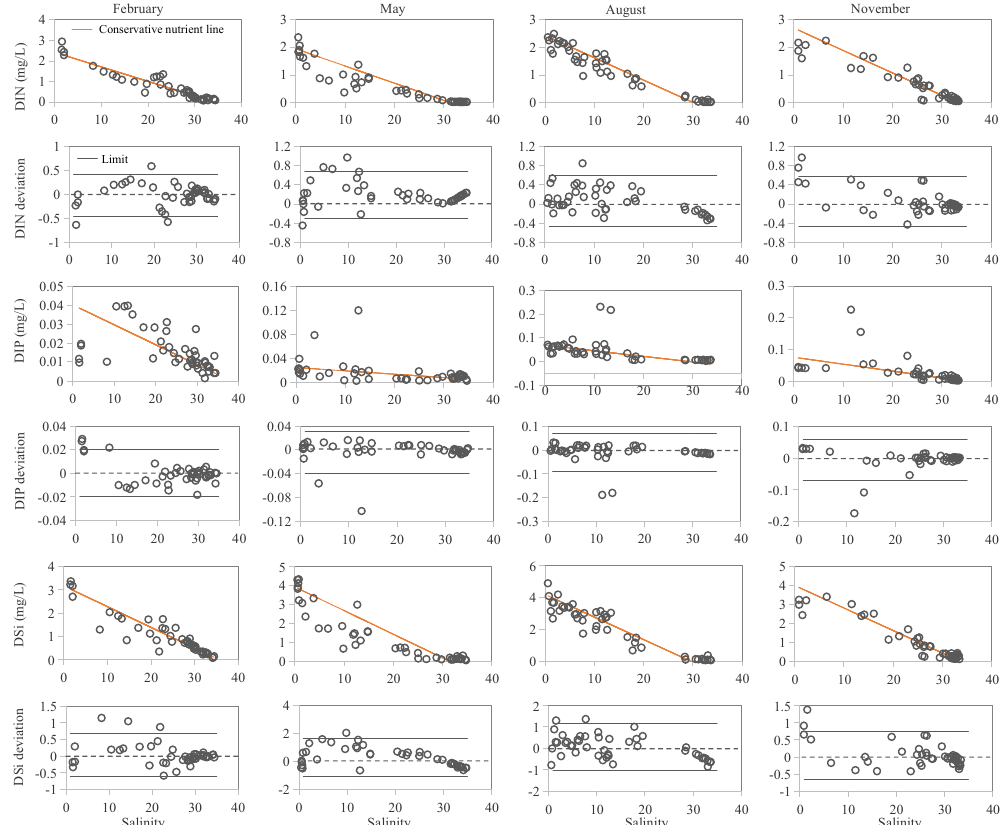
Figure 7. Seasonal change of nutrient deviation ( ∆ DIN, ∆ DIP, and ∆ DSi) vs. salinity in the surface samples, plots denoting the differences between the observed concentrations, and predicted values by the two end-member mixing model. The dashed line represents no deviation; the positive and negative deviations represent the nutrient input (e.g., emissions of coastal cities, riverine input, atmospheric deposition) and removal (e.g., biological uptake, sedimentation of particles). The limit lines indicate the nutrient deviations within 95% confidence